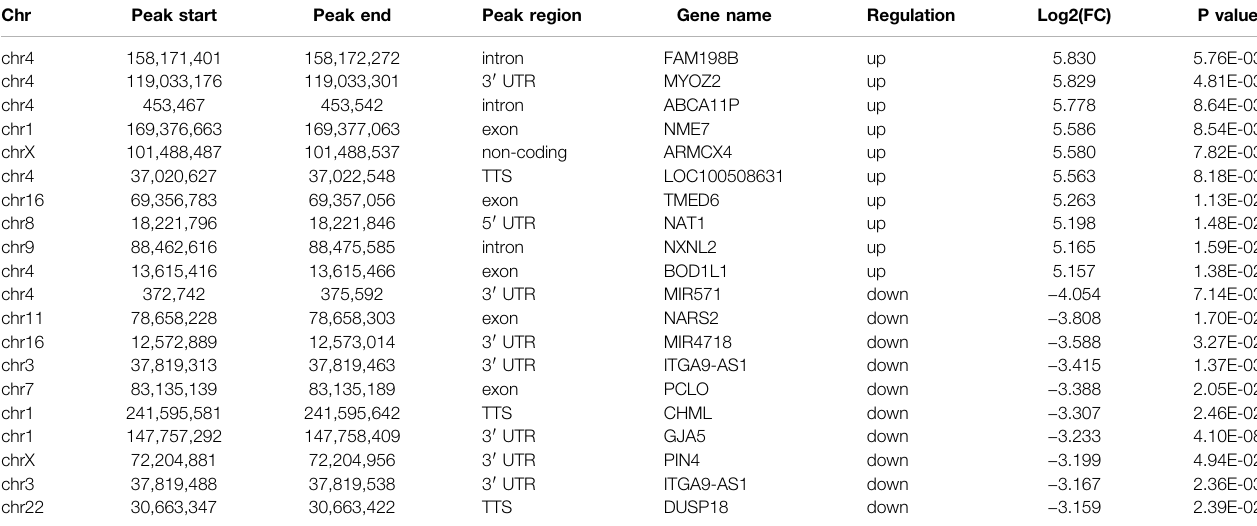
TABLE 1 | Top 20 altered m 6 A peaks in human villi during spontaneous abortion in the fi rst trimester. Chr Peak start Peak